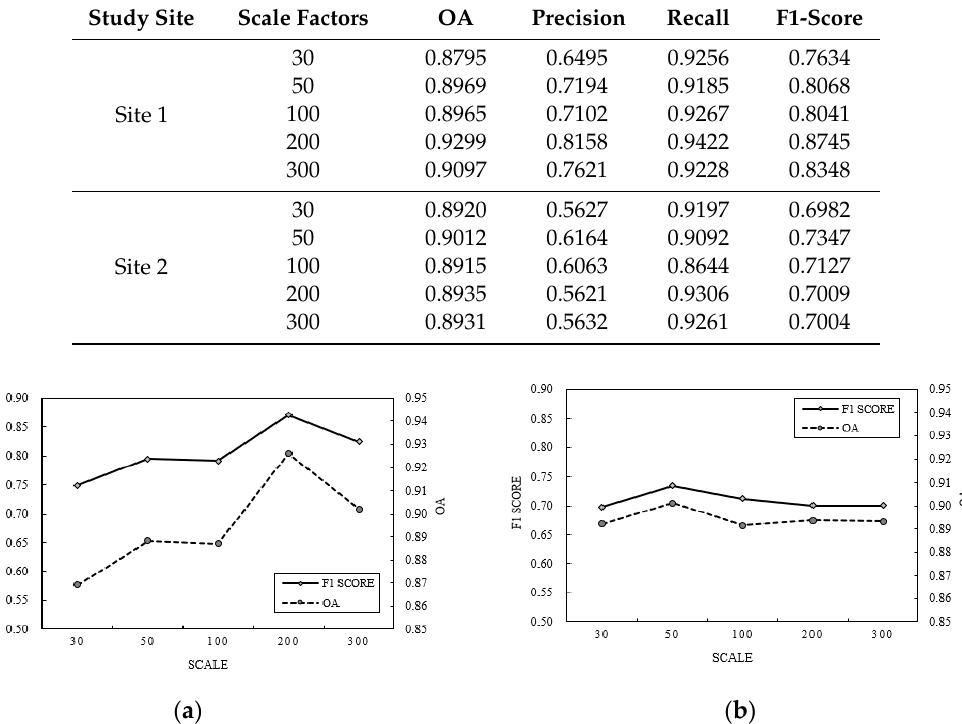
Figure 18. F1 scores and OAs with different scale factors at: ( a ) Site 1; and ( b ) Site 2.